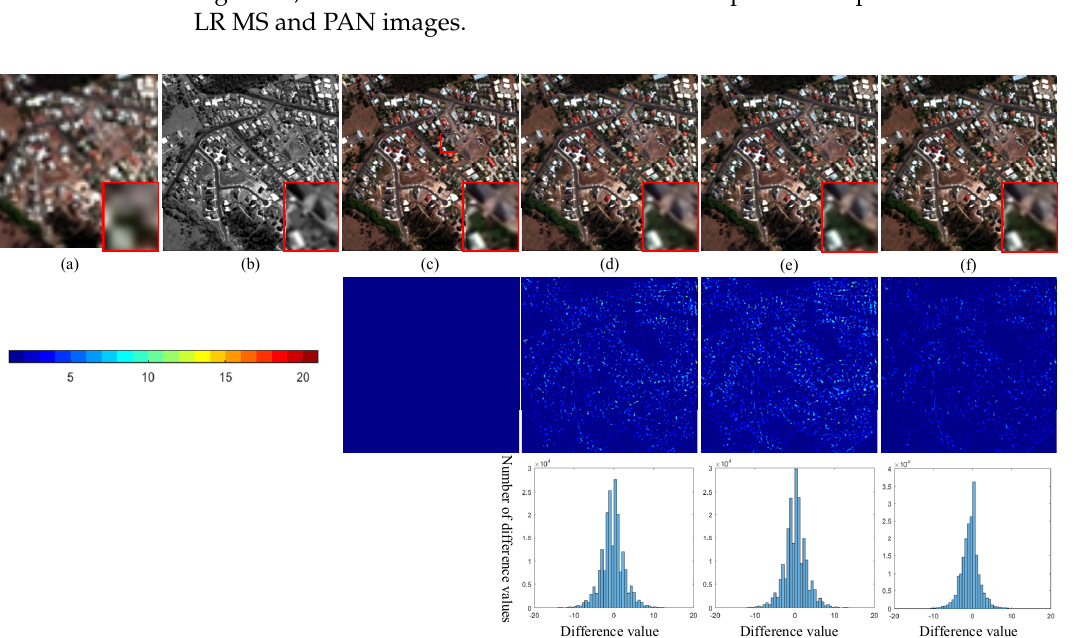
struction errors in Figure 11, we can find that SIAM can extract the spatial and spectral